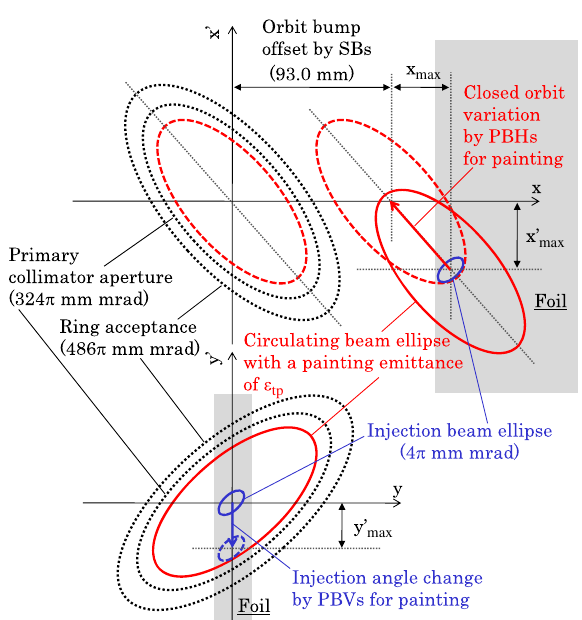
FIG. 3. Schematic diagram of transverse injection painting, where the upper plot is for the horizontal phase space, while the lower one is for the vertical